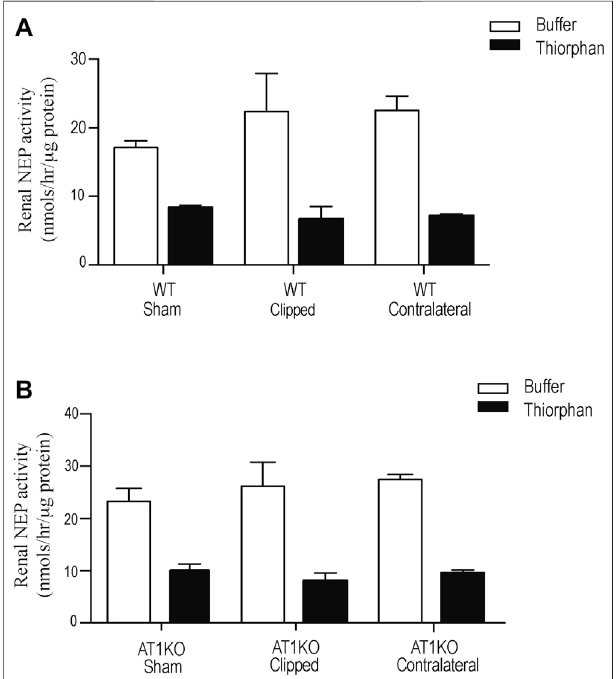
FIGURE 8 | Effect of renovascular hypertension on Renal NEP activity in Sham, Clipped and Contralateral kidneys using fl uorogenic enzyme assay: Renal NEP activity was measured using 1 µg of kidney samples and fl uorogenic NEP substrate in presence and absence of the NEP inhibitor thiophen. Each bar represents mean ± SEM (n (cid:2) 6 –